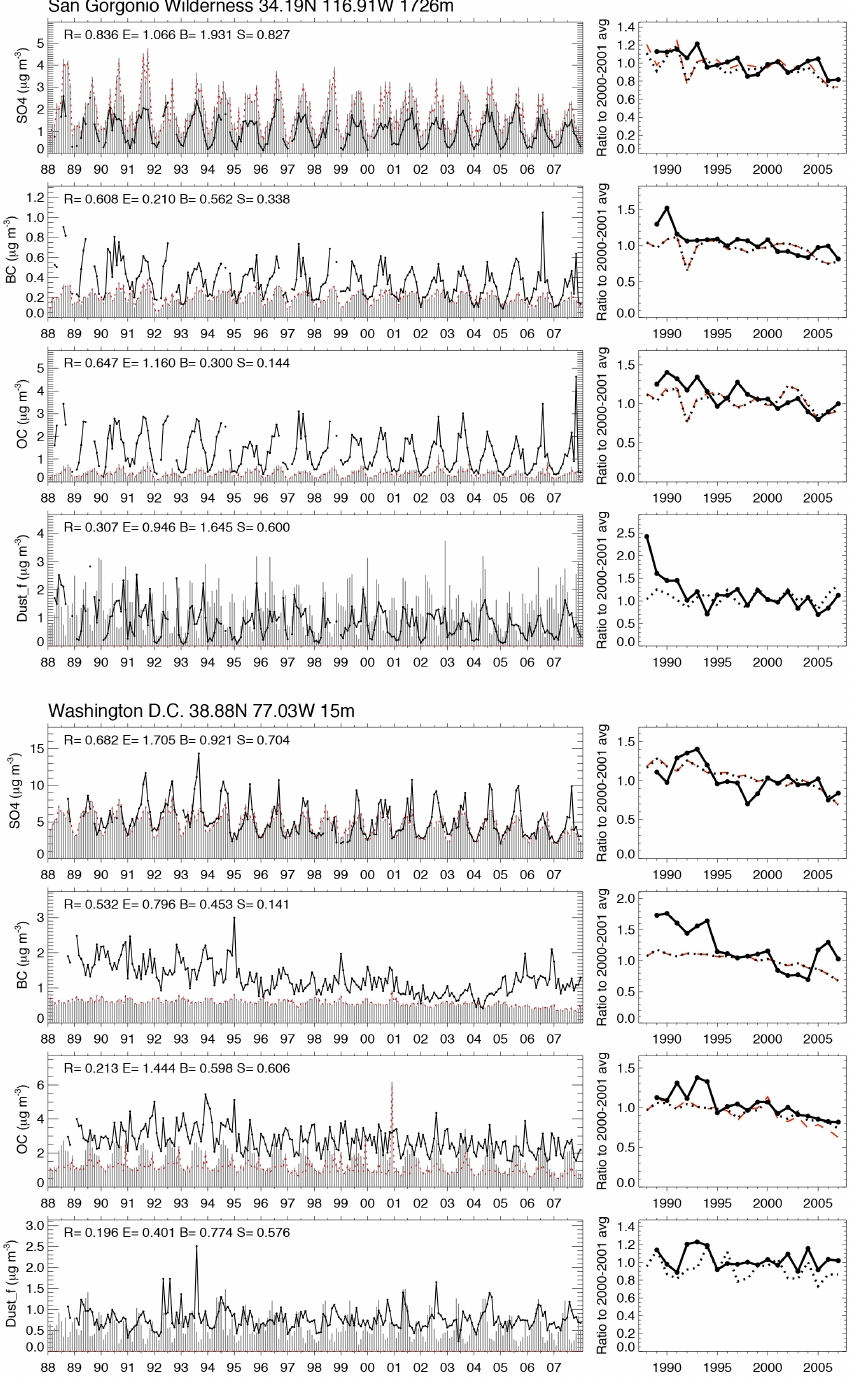
Fig. 8a. Left column: monthly averaged surface concentrations (µgm − 3 ) of sulfate, BC, OC, and fine mode dust from 1988 to 2007 at two US sites, San Gorgonio Wilderness in California, western US (top four rows) and Washington DC, eastern US (bottom four rows). Data from the IMPROVE network. Observations are shown in black lines and the model results in grey bars for total amount and dotted red lines for FF + BB amount. Statistical measures ( R , E , B , and S ) are defined as the same as in the Fig. 7 caption. Right column: ratio of annual mean concentrations to the 2000–2001 average at corresponding sites, showing the interannual variability/trend over the 20-year period with the observation and models in solid and dotted lines, respectively. Thin solid black line in the right column connects the points with missing year(s) in between for visual